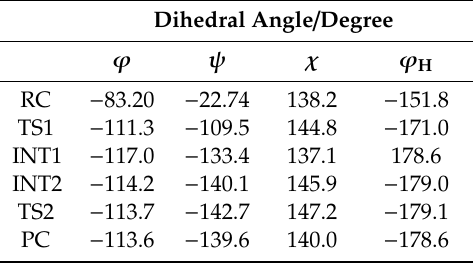
Table 5. Dihedral angles (degrees) of the optimized geometries for the anti conformation in the phosphate-catalyzed reaction. Dihedral Angle / Degree ϕ